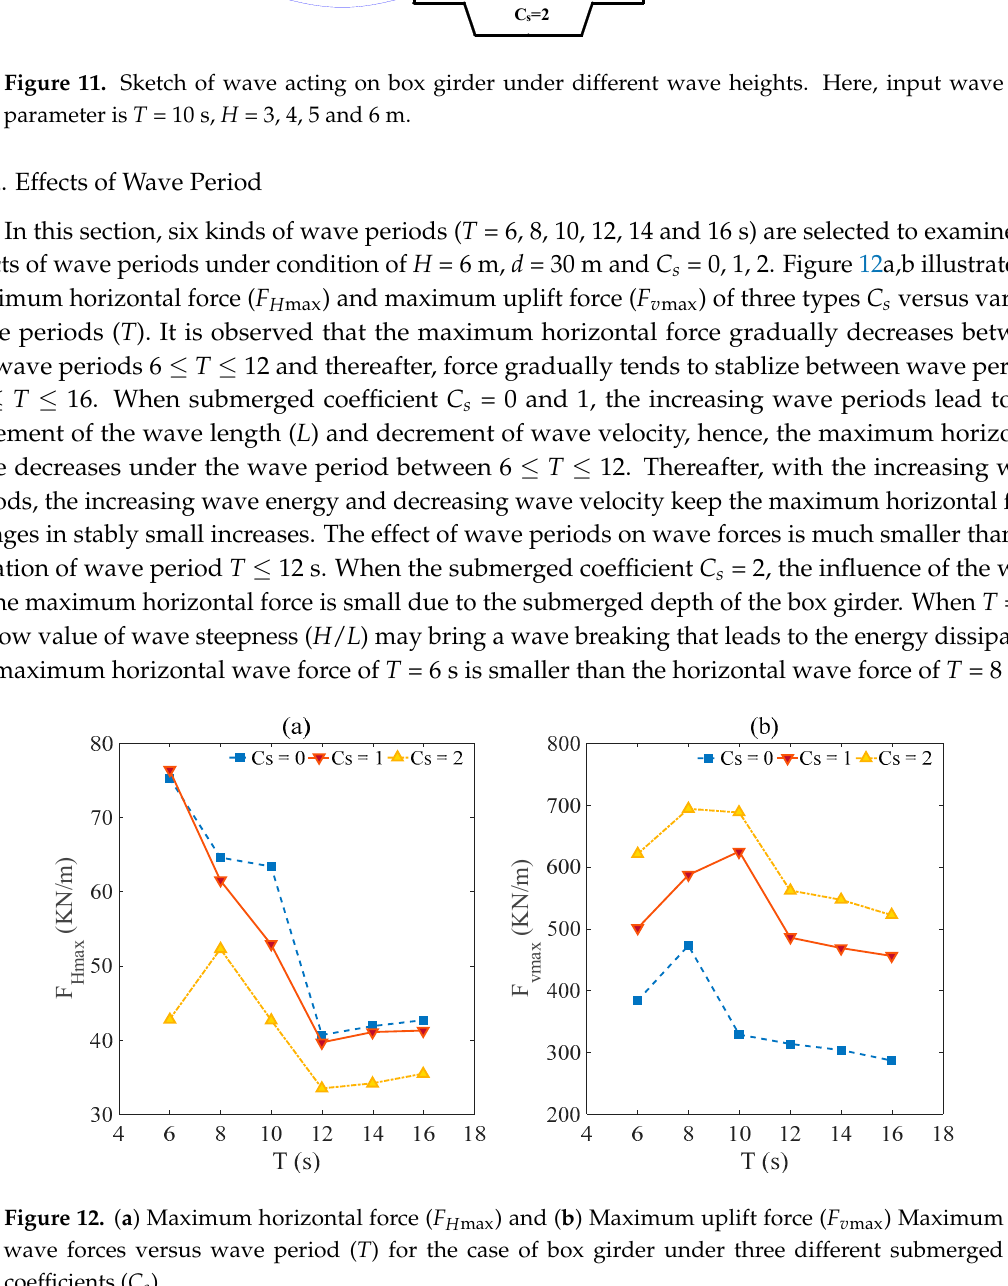
Figure 11. Sketch of wave acting on box girder under different wave heights. Here, input wave parameter is T = 10 s, H = 3, 4, 5 and 6 m.